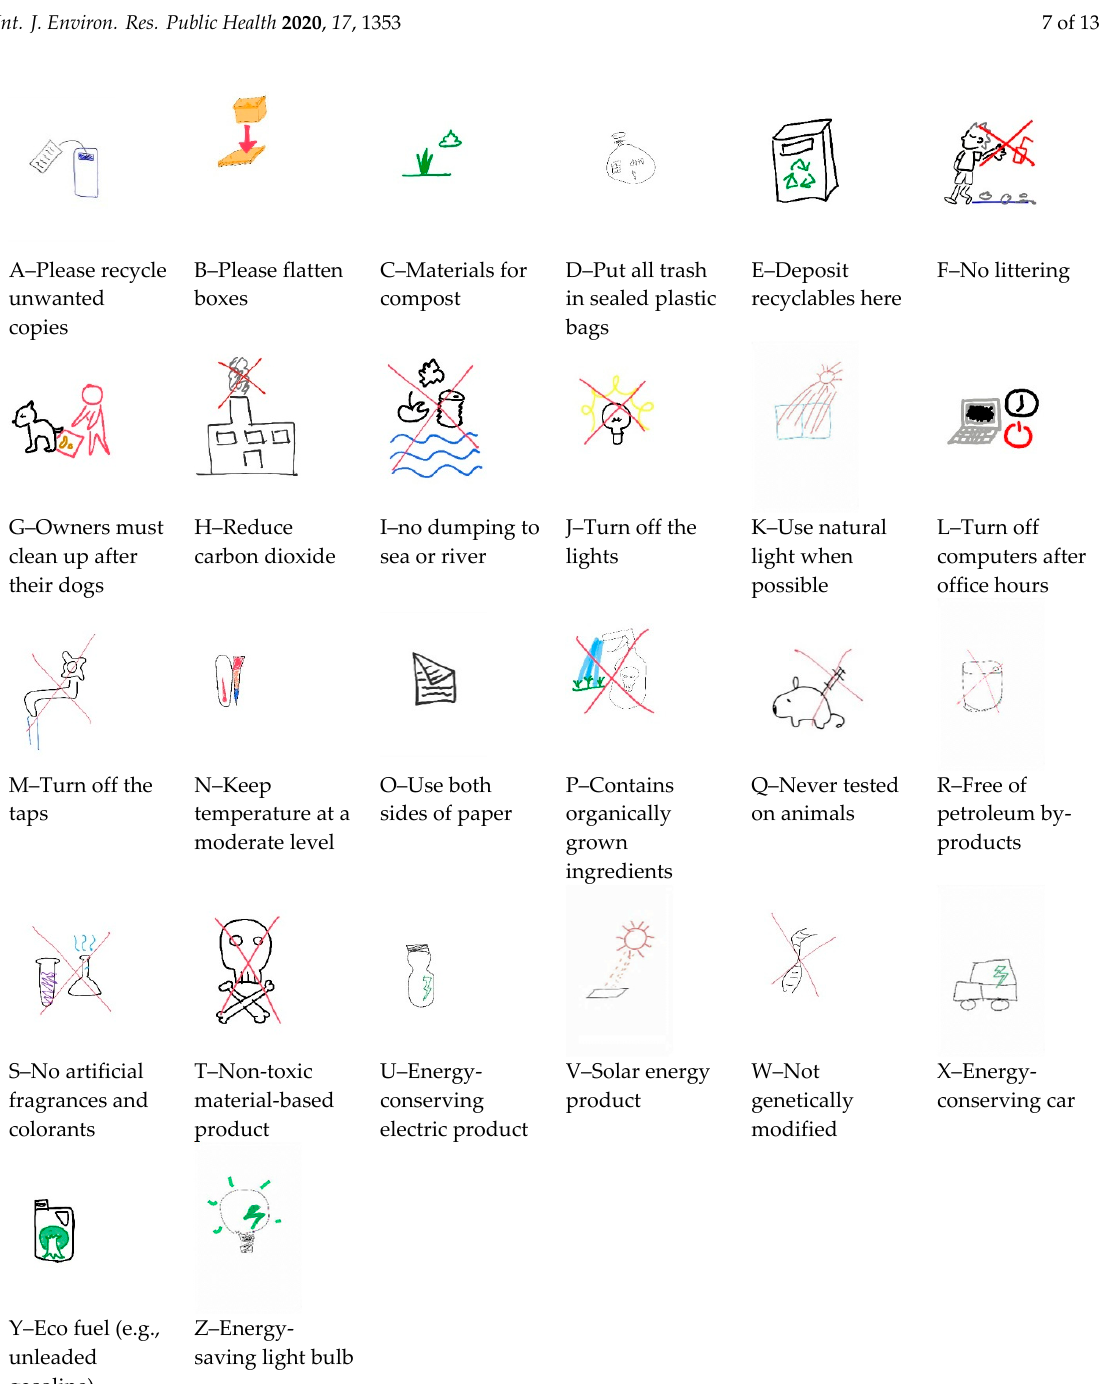
Figure 1. Samples of common representations for each environmentally friendly message from users.